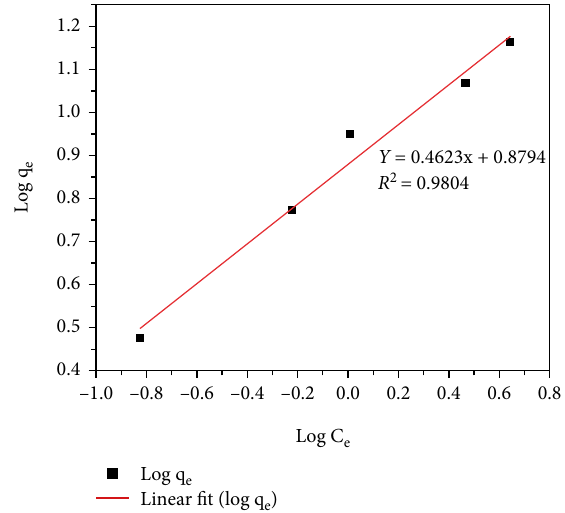
Figure 13: Freundlich isotherm model for adsorption of Pb (II) on CMNB at pH of 6, contact time of 50min, and adsorbent dosage of 0.9g/L.